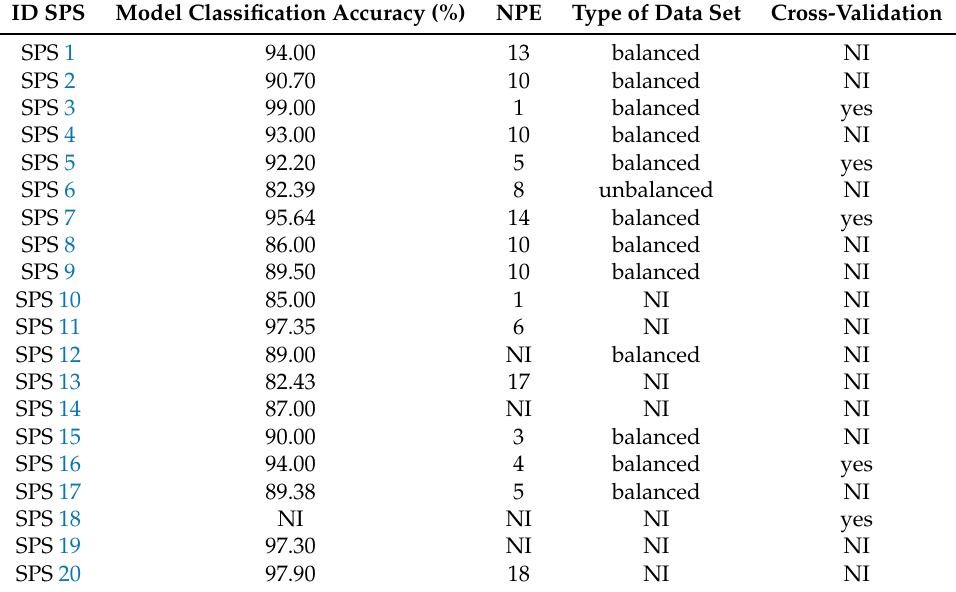
Table 13. The accuracy, number of people who participated in the evaluation, type of data set (i.e., balanced or unbalanced), and the use of cross-validation by the 56 HGR